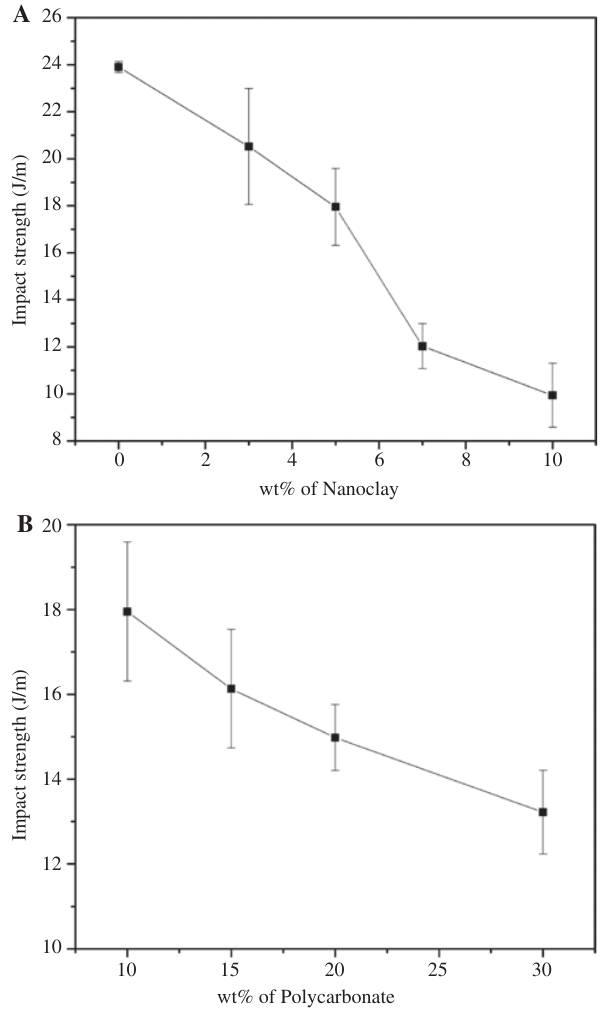
Figure 9: Izod impact strength at break of PP/PC nanocomposites: (A) Effect of NC content, (B) effect of PC